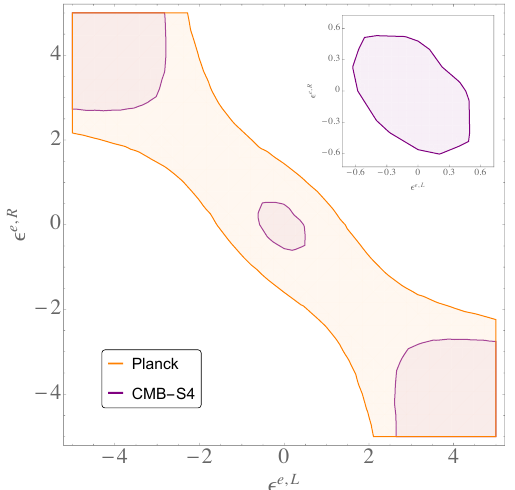
Figure 5 . Simultaneous constraints on (cid:15) e,L and (cid:15) e,R from precision measurements of N eff from Planck and CMB-S4. The allowed regions are indicated by the orange and the purple respectively. The subgraph in the upper right corner corresponds to the magnified allowed region from CMB-S4 near the origin. See the main text for a detailed